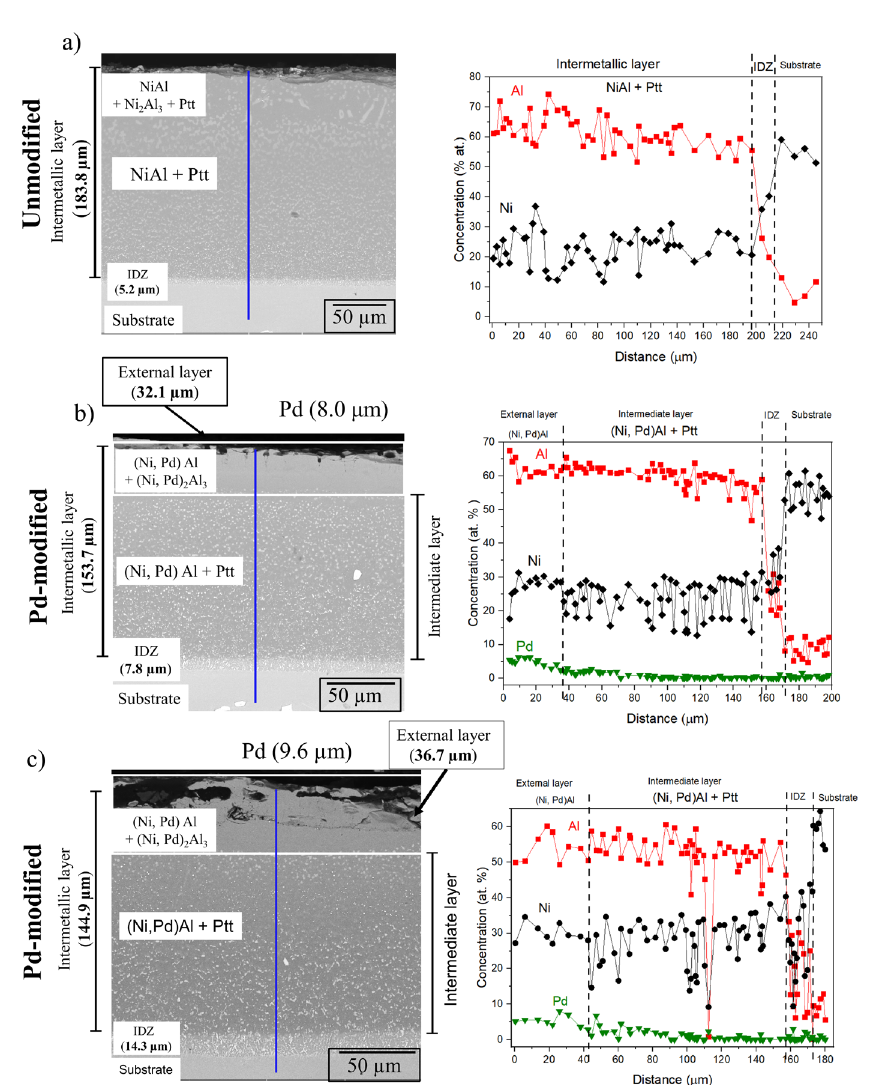
Figure 1. Cross section and chemical profile for Ni, Al and Pd of aluminized coatings (SEM, BSE mode) processed at 1030 °C: a) unmodified; b) and c) modified with Pd layers measuring 8.0 and 9.6 µm, respectively (Ptt: precipitates; IDZ: interdiffusion zone).